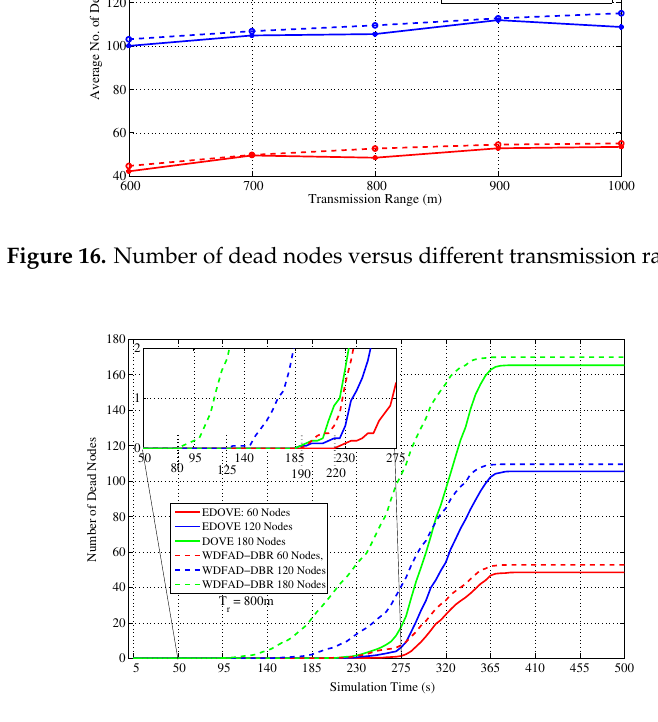
Figure 17. Number of dead nodes during simulation duration for the fixed network size and different transmission